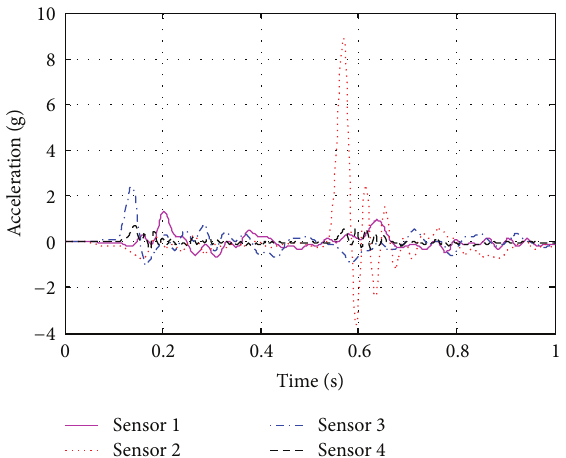
Figure 13: Accelerations with 𝑉 𝑦 = 0.75 m/s, 𝑉 𝑥 = 0 m/s, and 𝜃 = 10 ∘